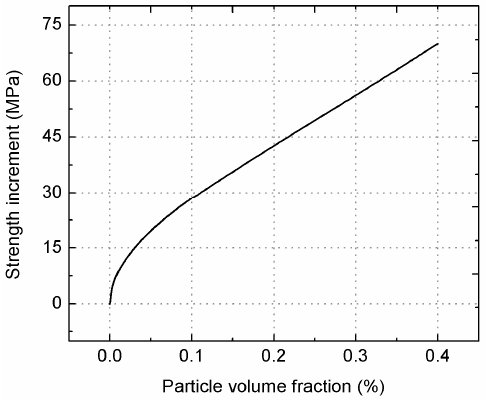
Figure 11. Dependence of the yield strength due to CTE mismatch on the reinforcement volume fraction.